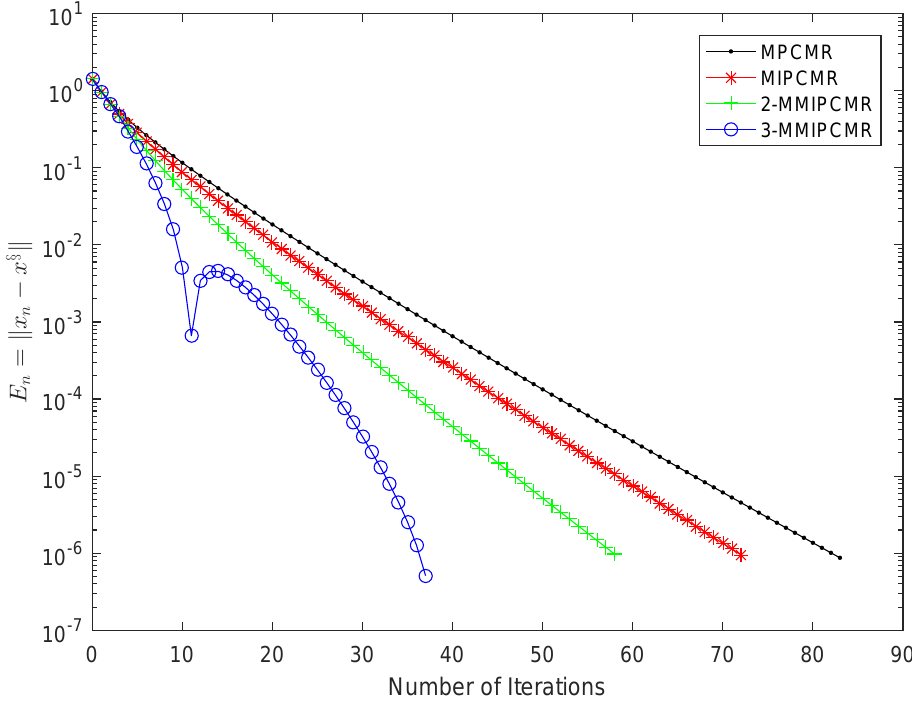
Figure 6. Comparison of MPCMR, MIPCMR, 2-MMIFBMR and 3-MMIPCMR in Example 3.